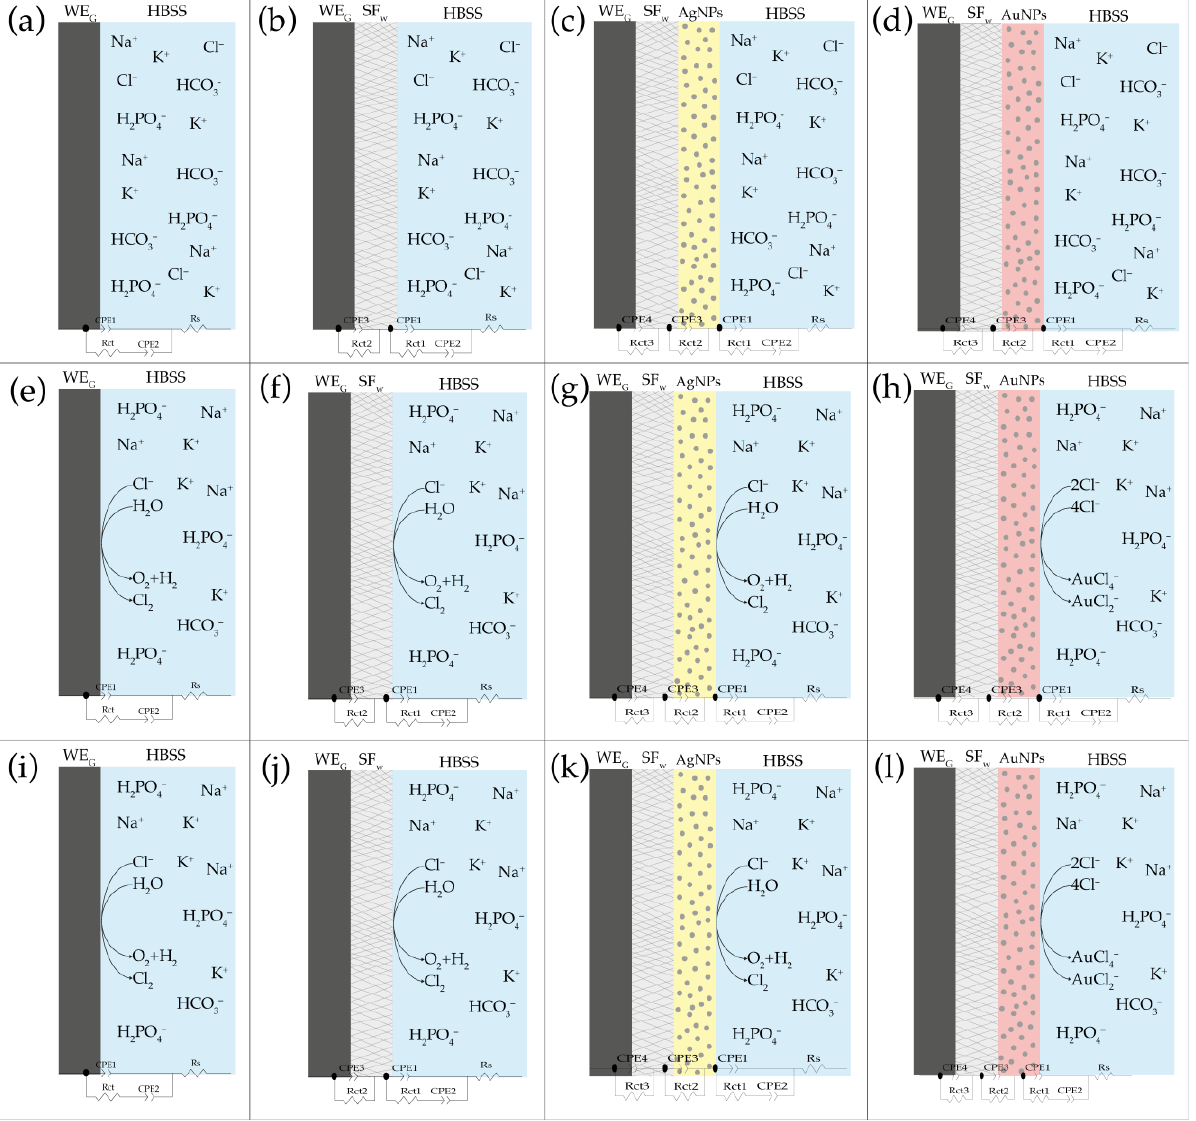
Figure 7. Schematic representation of the electrical behavior for the graphite electrode and the interaction with treated membranes with and without AuNPs-SF w or AgNPs-SF w functionalization, which describe the distribution of impedance components with their respective equivalent circuits to different DC electrical potentials. Where ( a – d ) 0 mV; ( e – h ) 400 mV; ( i – l ) 800 mV.